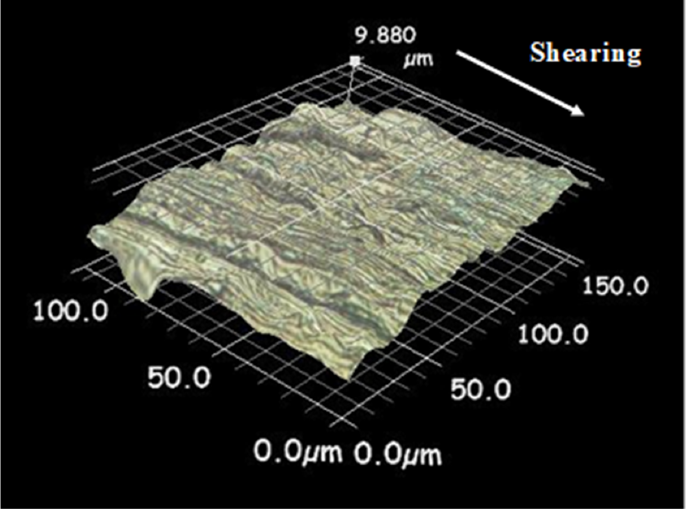
Figure 10. Three-dimensional surface profile of the sheared square blank using the CS-YXR7 punch.